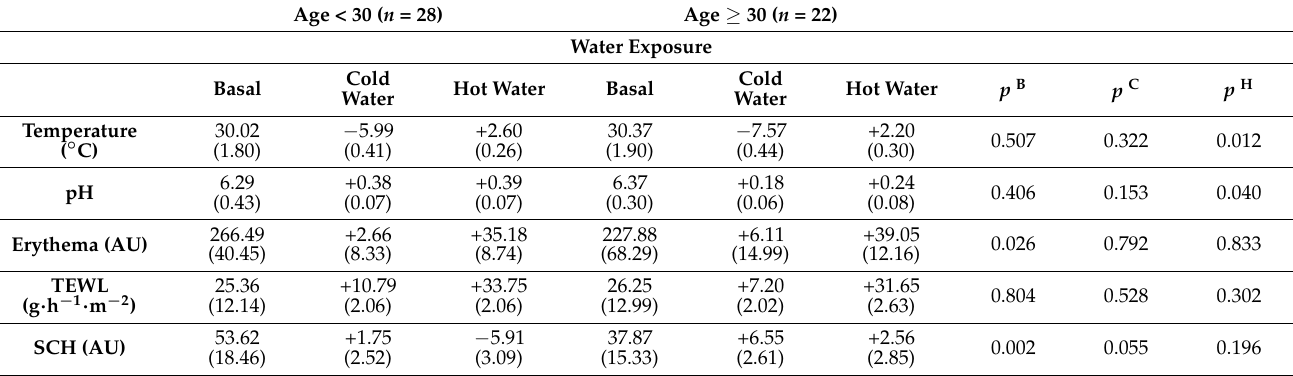
Table 3. Changes in skin barrier function after hot and cold water exposure, stratified by